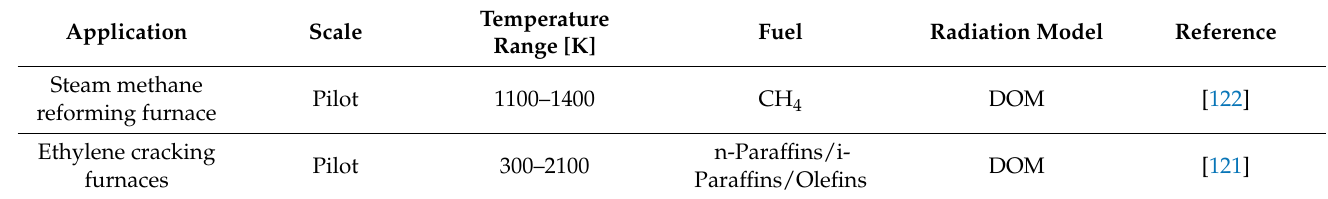
Table A3. Summary of utilized radiation modelling for different high temperature reactive flow